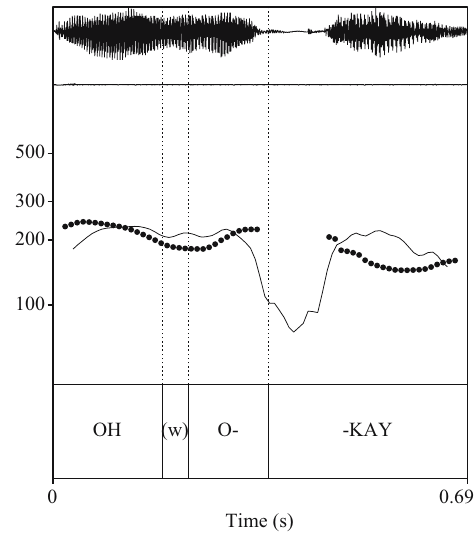
Figure 3: Pitch trace and intensity curve for line 18 in Ex. ( 7 ) “ Out of touch ”